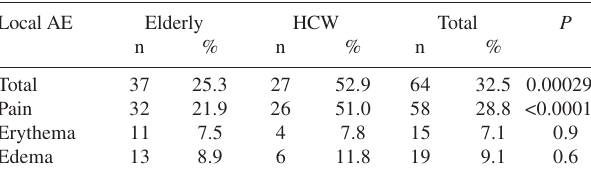
Table 3 - Occurrence of local adverse events after